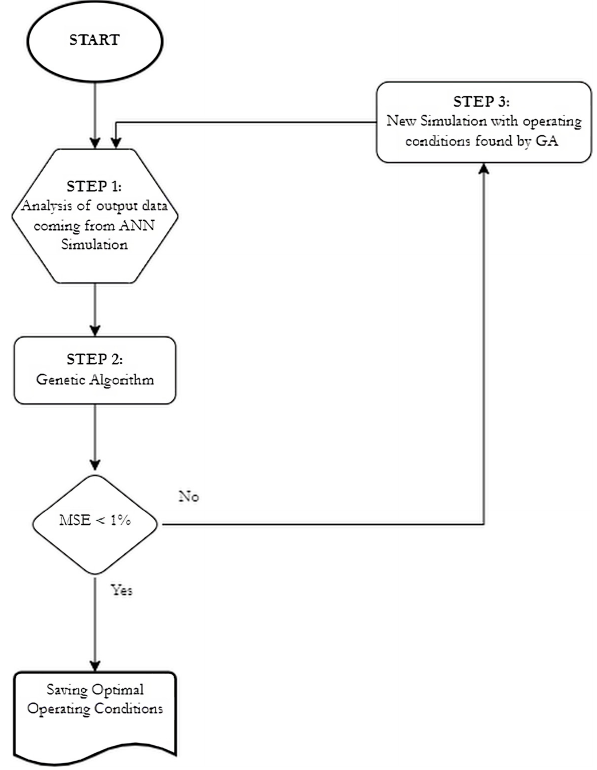
Figure 2. Optimization strategy of the input parameters.